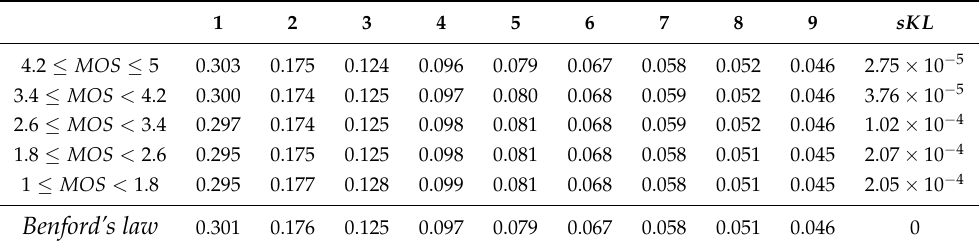
Table 7. Mean FDD of higher-order singular values in KoNViD-1k [22] with respect to different MOS intervals. In KoNViD-1k [22], the lowest possible video quality is represented by MOS = 1.0, while MOS = 5.0 stands for the highest possible video quality. In the last column, the symmetric Kullback–Leibler ( sKL ) divergences between the actual FDD and the Benford law distribution are